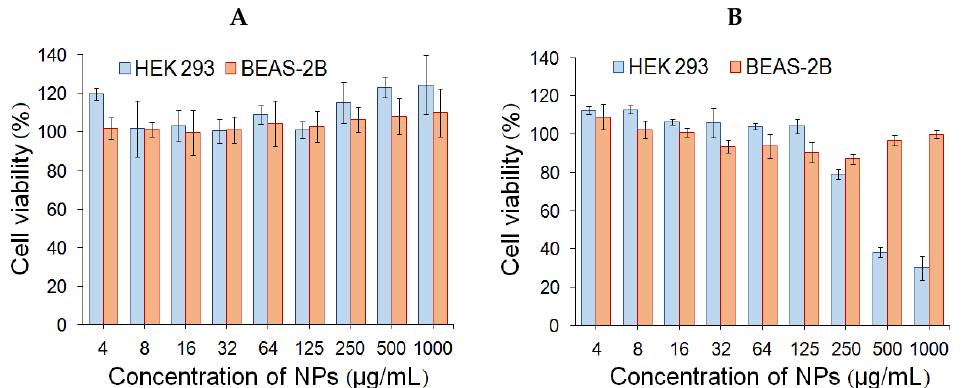
Figure 11. Cell viability of HEK293 and BEAS-2B cells during 24 h ( A ) and 72 h ( B ) for PVSAA - b- PChMA- b -PVSAA nanoparticles.